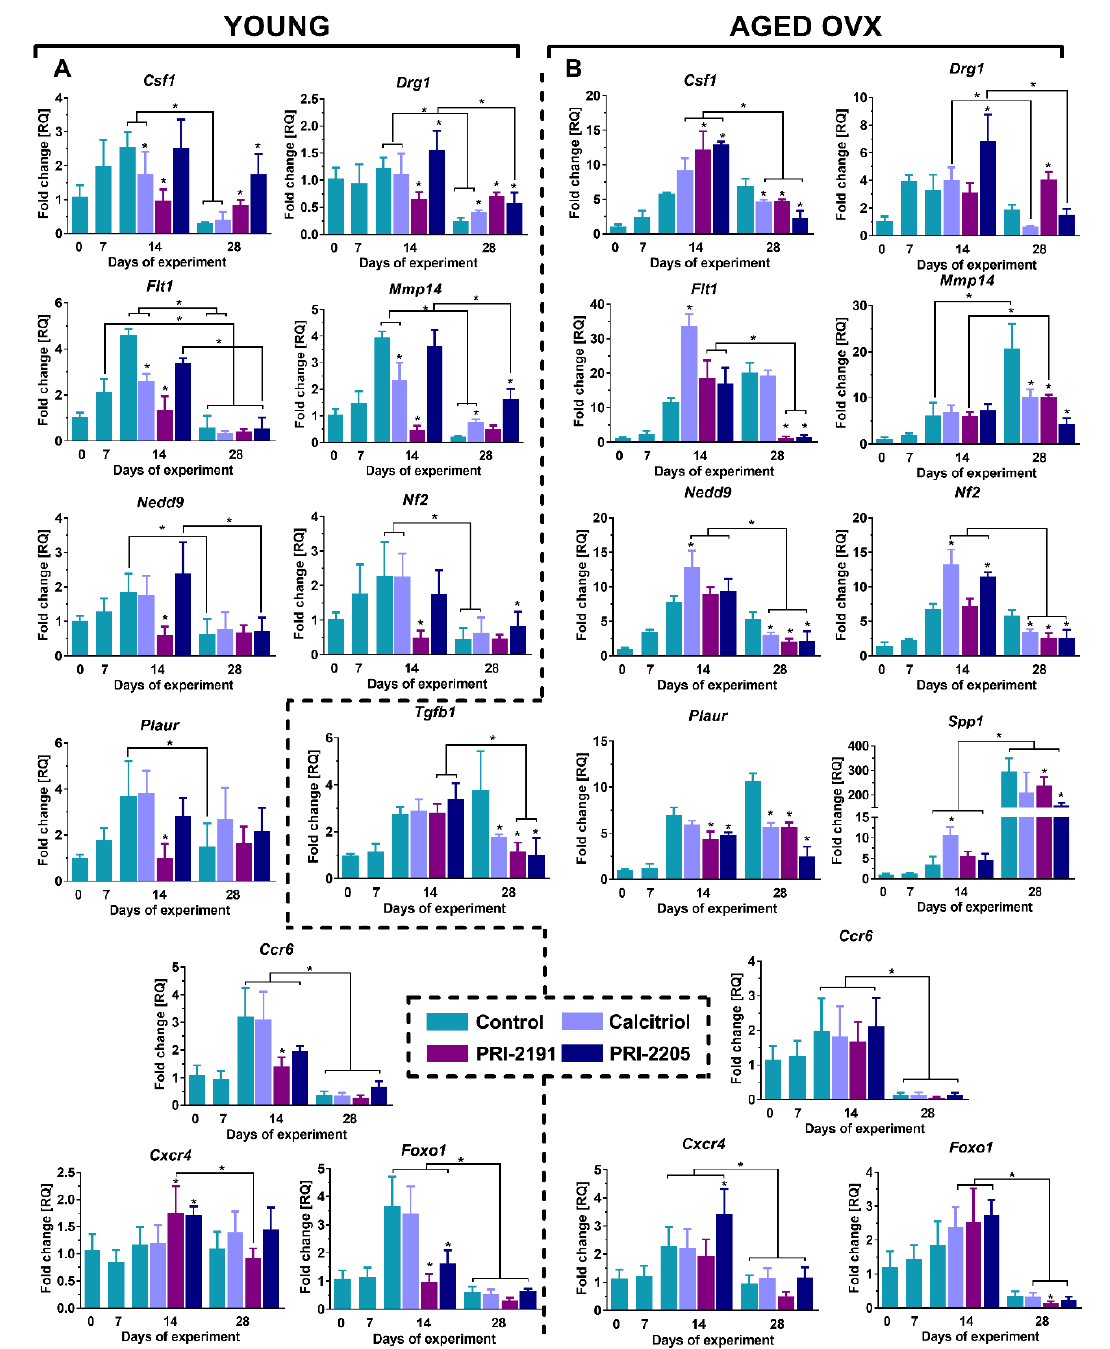
Figure 3. Changes related to gene expression in the lungs of 4T1 tumor-bearing young and aged OVX mice. Expression of selected genes in lung tissue of ( A ) young or ( B ) aged OVX mice estimated by real-time PCR is presented. The analysis was performed on tissue samples harvested at days 0, 7, 14, and 28. 25 ng of cDNA was used for a single reaction and each sample was applied in triplicate (day 0). Ribosomal protein L13a gene ( Rpl13a ) was used as a housekeeping gene in the analysis. Briefly, 60-